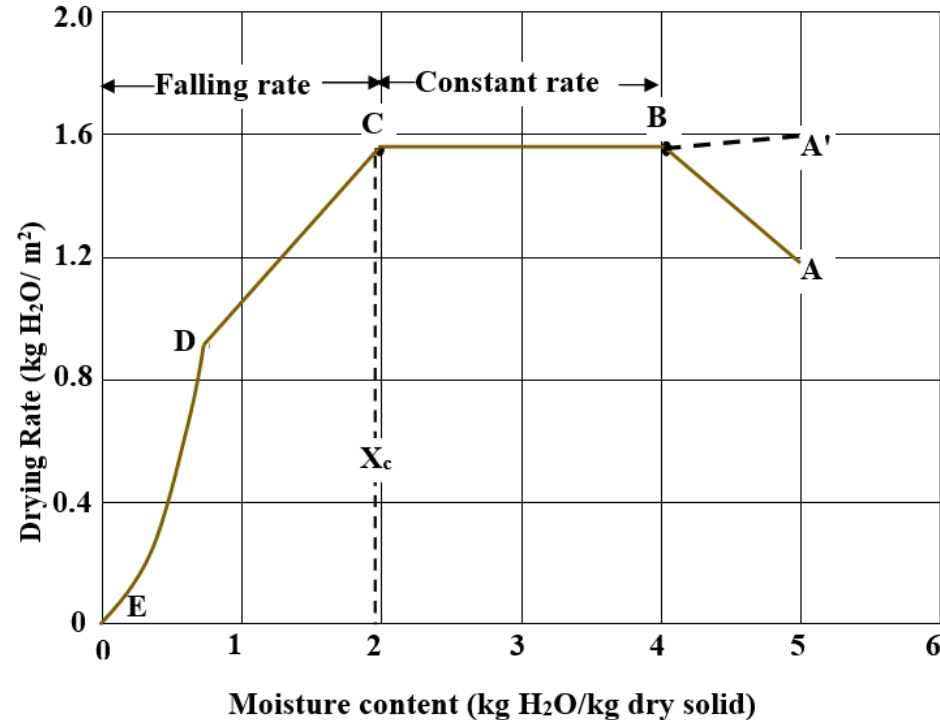
Figure 2. Drying kinetics as a function of moisture